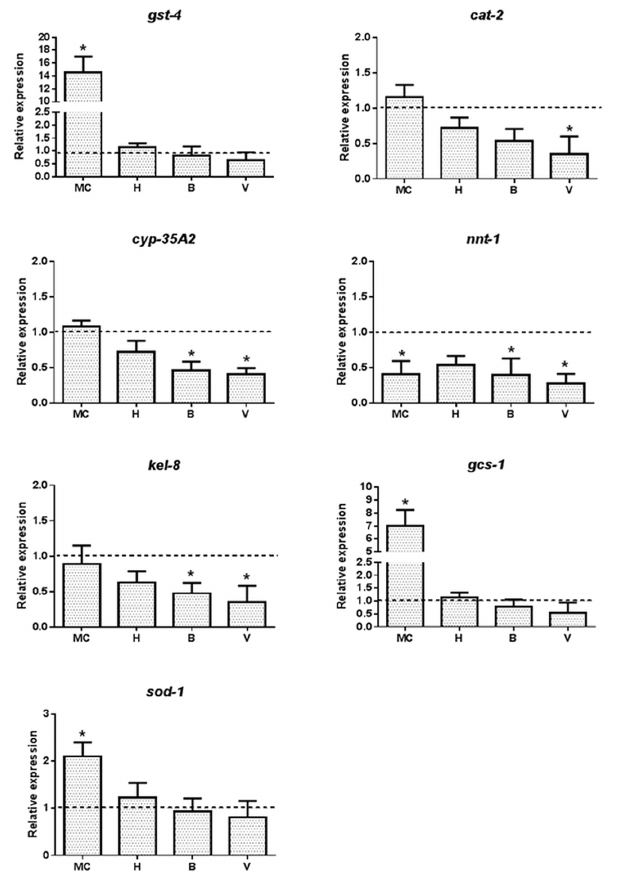
Fig 3. Exposure of C . elegans to metals affects the expression of oxidative stress response genes. Synchronized C . elegans treated with the metal cocktail (MC) or waters from Lake Hornträsket (H) and Vormbäcken stream at Björk å s (B) and the exit to Vindelälven (V) were analyzed for the expression of gst-4 , sod-1 , cat-2 , cyp-35A2 , daf-2 , nnt-1 , kel-8 and gcs-1 using qRT-PCR. One way analysis of variance (ANOVA) followed by Tukey ’ s post-test was used for multiple group comparison where * refers to p < 0.01 as compared to control and # represents significant differences in between sites H, B and V. The dotted line represents the expression level normalized to that of the control (K-medium prepared with Milli-Q